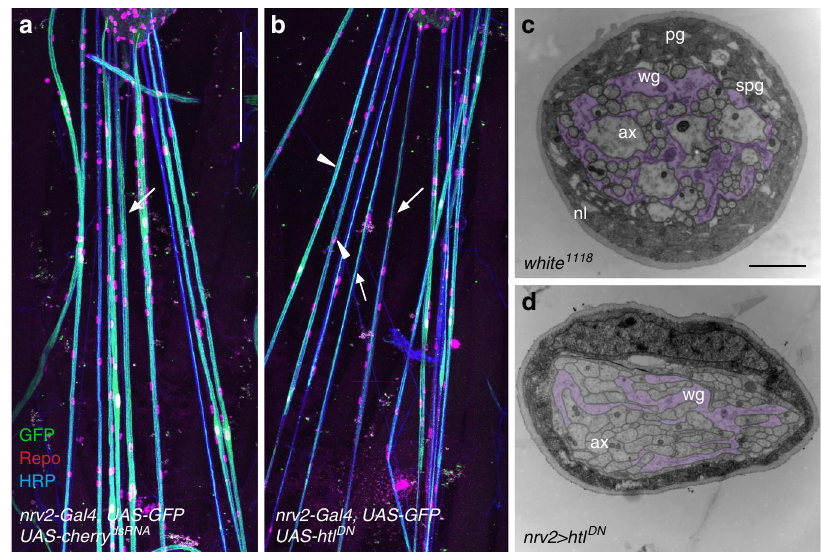
Fig. 2 FGF-receptor Heartless controls differentiation of the wrapping glia. a , b Filet preparations of a third instar larvae with a genotypes as indicated stained for Repo expression (red), GFP (green), and HRP (blue). Representative images are shown taken from >10 animals analyzed for each genotype. b Note that upon expression of htl DN , the wrapping glia appears thinner (arrows). Scale bar is 200 µ m. c , d Electron microscopic images of segmental nerves taken at about 160 µ m distance to the tip of the ventral nerve cord of wandering third instar larvae. Five or more specimens were fi xed and embedded in a fi lleted form. Representative images are shown for each genotype. Scale bar is 2 µ m. c Cross-section of a control nerve ( white 1118 ). The nerve is surrounded by a neural lamella (nl). The perineurial glia (pg) and the subperineurial glia (spg) form the blood – brain barrier. The wrapping glia (wg) engulfs all axons (ax). The wrapping glia is highlighted by purple staining. d Cross-section of a nerve from an animal of the genotype [ nrv2-Gal4 ; UAS-htl DN ]. Note that differentiation of the wrapping glia (purple shading) is compromised. A similar phenotype is seen in larvae of the